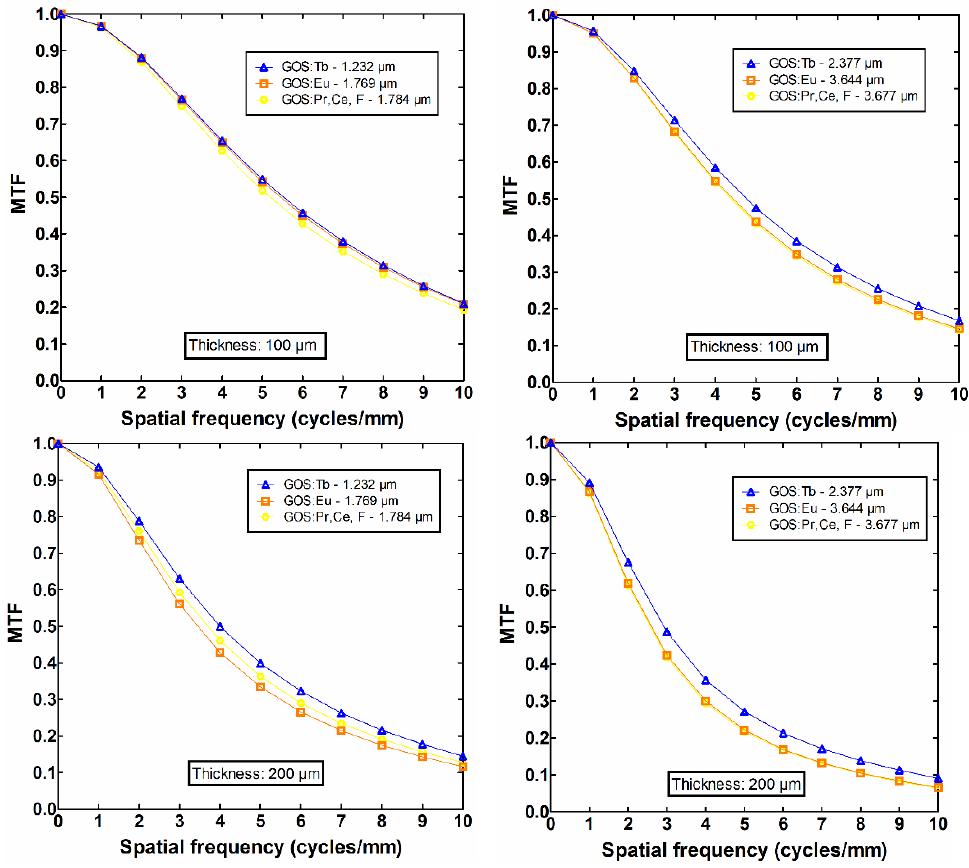
Figure 8. MTF curves of two phosphor layers, 100 μ m ( upper images ) and 200 μ m ( lower images ). Two comparable sets of GSDs of approximately similar size were considered: (i) 1.232 μ m, 1.769 μ m, and 1.784 μ m ( left side ), and (ii) 2.377 μ m, 3.644 μ m, and 3.677 μ m ( right side ), for Tb, Eu, and Pr,Ce,F, respectively. Table 3. Light emission performance (absorption, transmission, and reflection) of different GSD